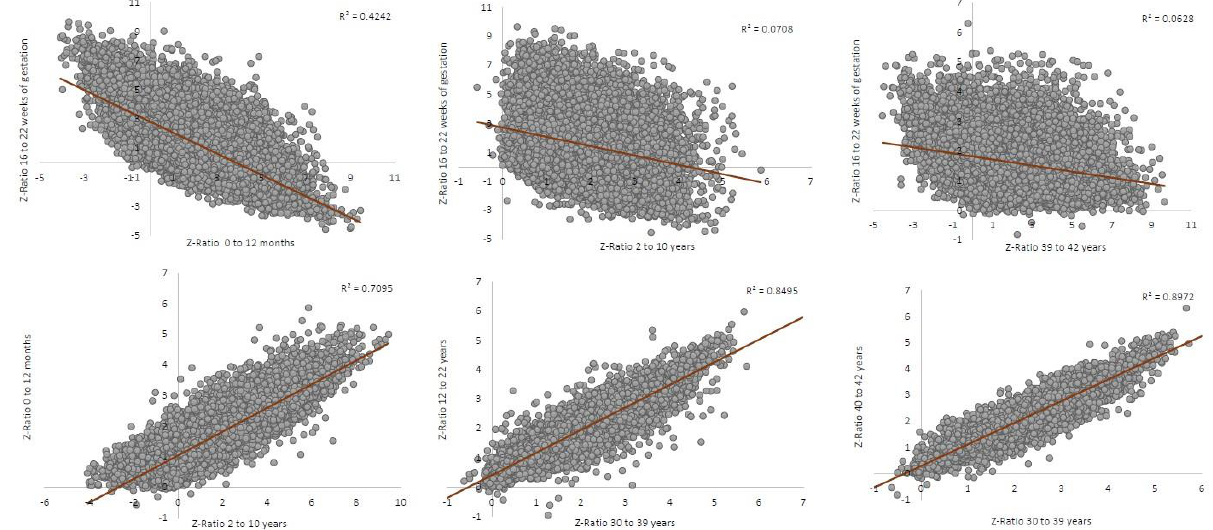
Figure 2. Z-ratio correlation among different age-ranks in the brain samples of Down syndrome.